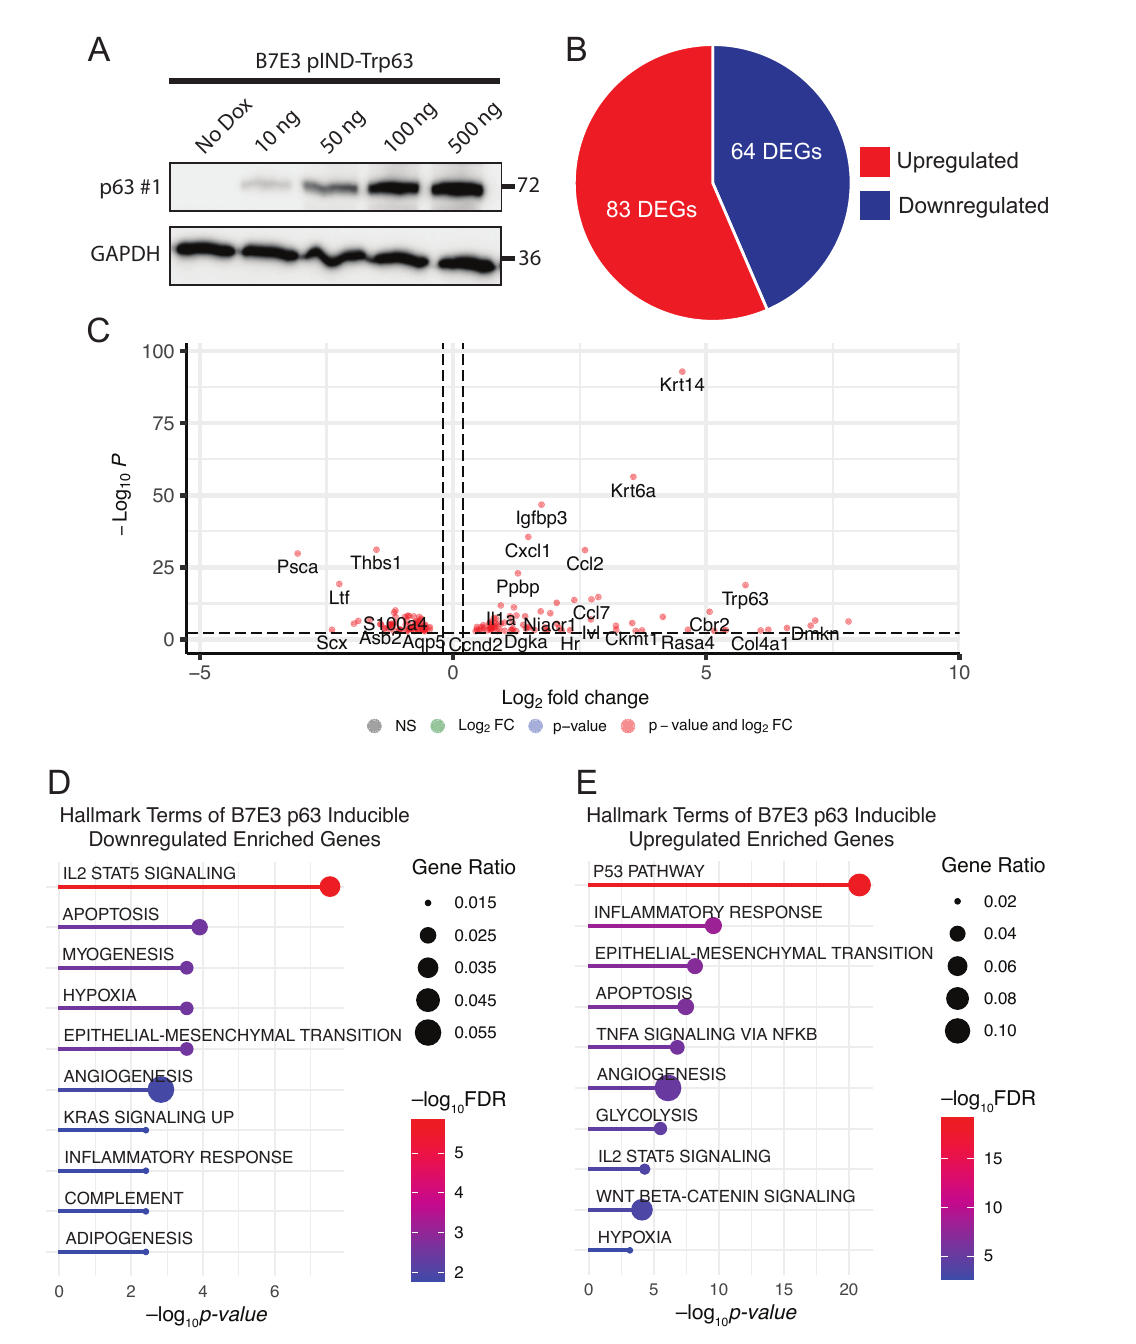
Figure 4. p63 overexpression in p63 low B7E3 cells. ( A ) Western blot analysis of p63 expression in B7E3 cells with dox-inducible p63 expression. GAPDH was used as a loading control. A pie chart ( B ) and a volcano plot ( C ) of DEGs resulting from induced p63 overexpression in B7E3 cells. Enriched hallmark terms in downregulated ( D ) and upregulated ( E ) DEGs in p63-overexpressing B7E3